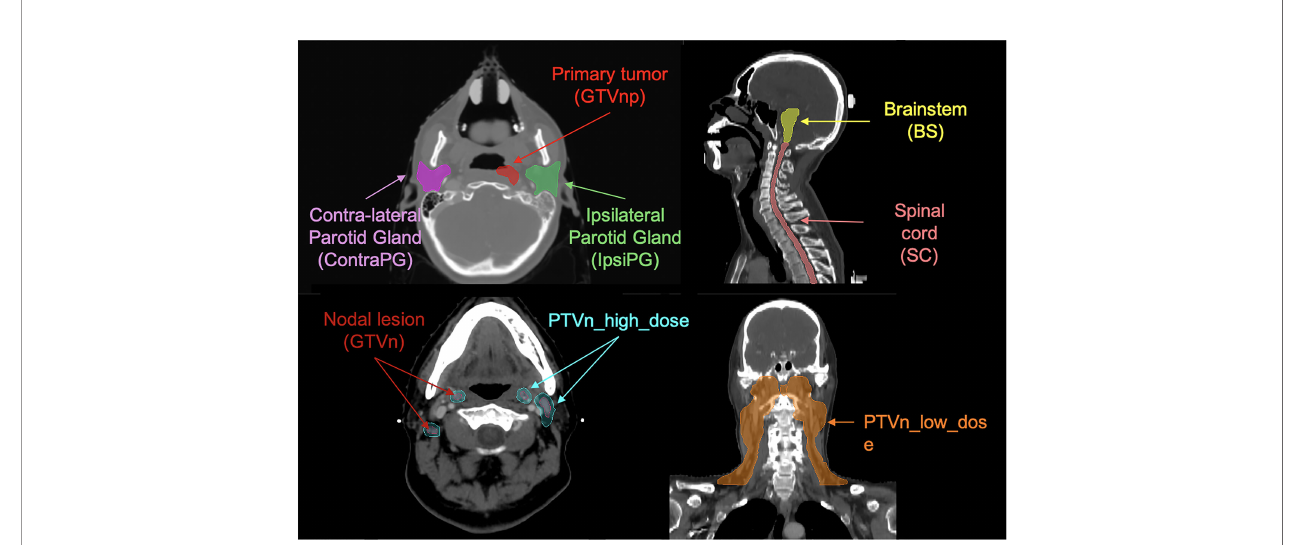
FIGURE 1 | Illustration of the eight VOIs involved in this